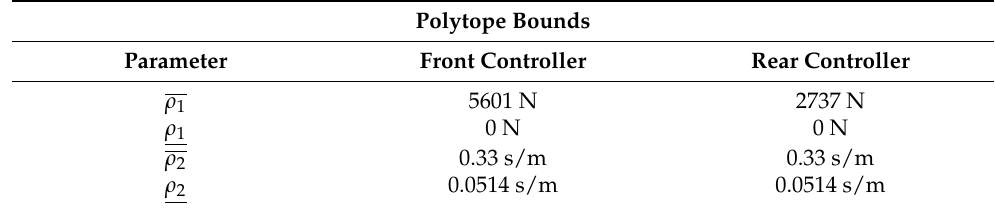
Table 2. Polytopes bounds.